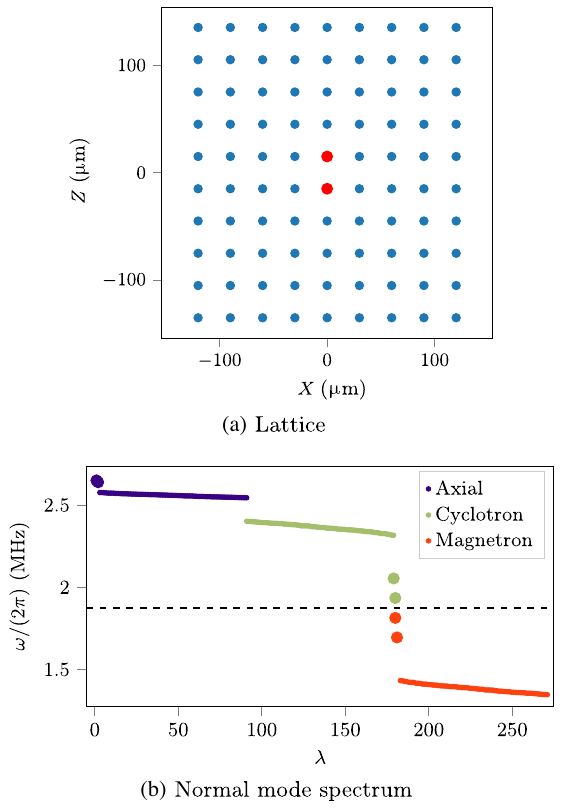
FIG. 9. (a) 90-ion square lattice of beryllium ions, with two selected ions (shown larger) in a potential well with a different curvature from all of the others, achieved by local tuning of the electrode voltages. (b) Normal-mode frequencies for the lattice considered. Modes 1 – 90 are axial modes, 91 – 180 are modified cyclotron modes, and 181 – 270 are magnetron modes. The isolated modes of the ions at two selected sites are shown with enlarged symbols, corresponding to mode indices 1 and 2, 179 and 180, and 181 and 182. Because of their frequency separation from the bulk, these modes are largely isolated. The horizontal dashed line indicates half the bare cyclotron frequency ω